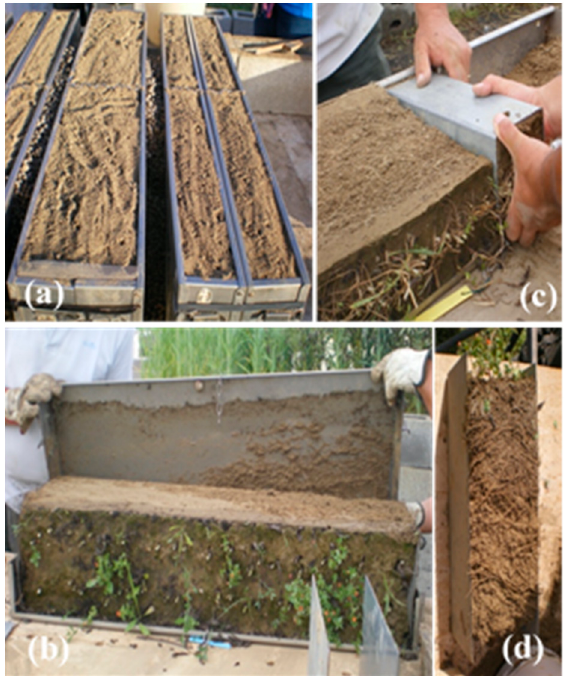
Figure 9. Growth boxes of Full ( a , left) and Aerial ( b , right) treatments; side front removal from a growth box at harvest ( b ); a soil column during ( c ) and after excavation ( d ).